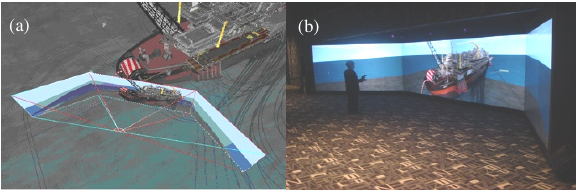
Figure 1. Environ: (a) User stand in front of a cave composed by three view screens. (b)Virtual representation of the cave in (a) and user’s position using multi-projection calculations.